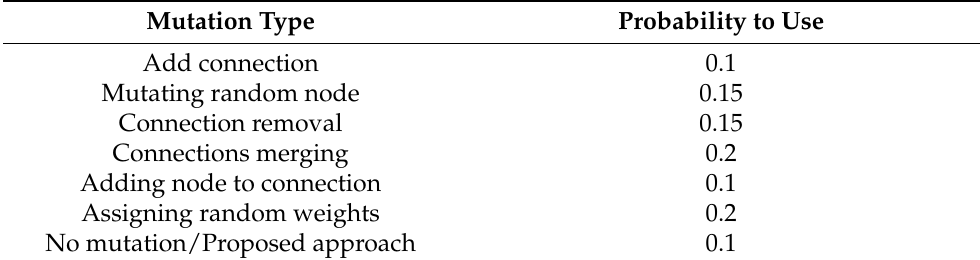
Table 1. Probabilities of mutation operators in